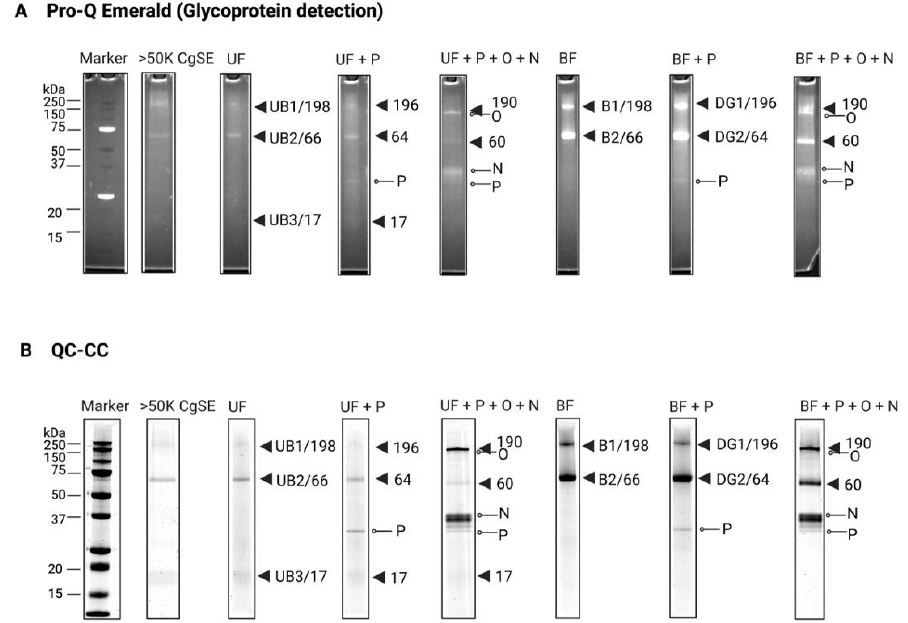
Figure 2. Enzymatic deglycosylation and glycoprotein staining profiles. ( A ) Unbound and Bound fractions eluted from WGA affinity chromatography were enzymatically deglycosylated with PNGase F (P), O -glycosidase (O), and Neuraminidase (N). Ten µg of each sample was loaded on a 12% SDS-PAGE and the gel was stained by Pro-Q emerald for Glycoprotein detection. ( B ) The gel was subsequently double-stained with QC-Colloidal Coomassie (QC-CC) Stain. Abbreviations: UF, Unbound Fraction; BF, Bound Fraction; UB1-UB3, B1, B2, DG1, DG2, S1, and S2 bands correspond to the identified proteins in the mass spectrometry analyses and are summarized in Tables 1 and 2. This figure was created using BioRender.com (accessed on 25 July 2022).